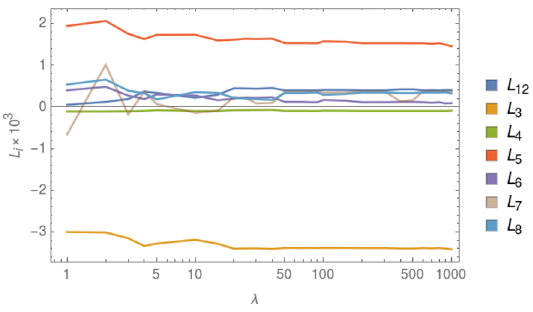
=(cid:21) with (cid:21) (right). (cid:21)